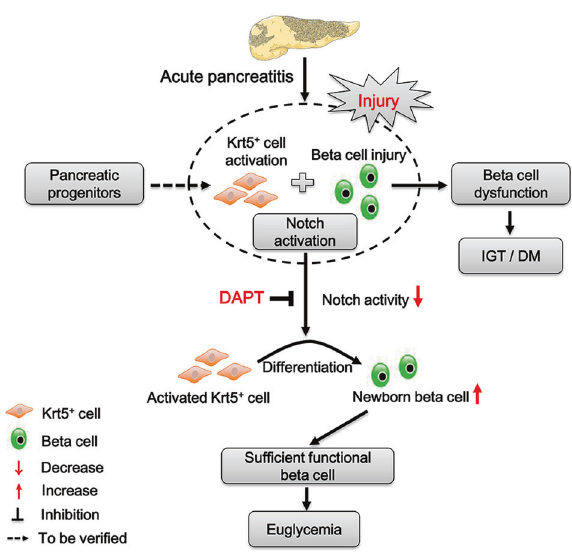
Fig. 8 Diagram of potential mechanism of Notch inhibition in pancreatic Krt5 + cell differentiation and glucose tolerance restoration following AP. After AP, beta-cell loss induces IGT or even DM. At the same time, Krt5 + cells are activated together with upregulated Notch activity. Subsequent Notch inhibition would contribute to the differentiation of Krt5 + cells toward functional beta cells, thus restoring the glucose homeostasis. DM, diabetes mellitus; IGT, impaired glucose